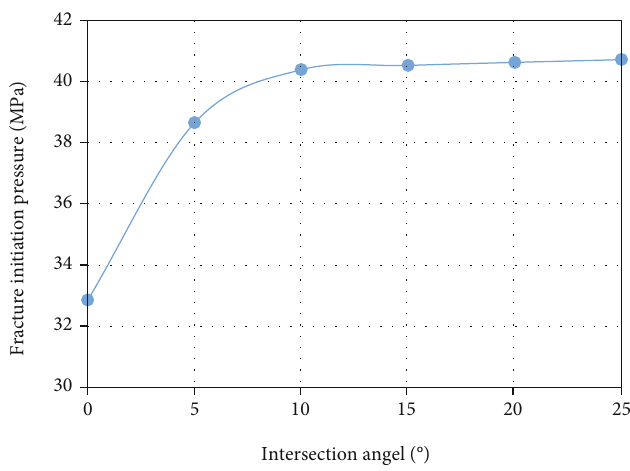
Figure 4: FIP with di ff erent intersection angles between radial boreholes.